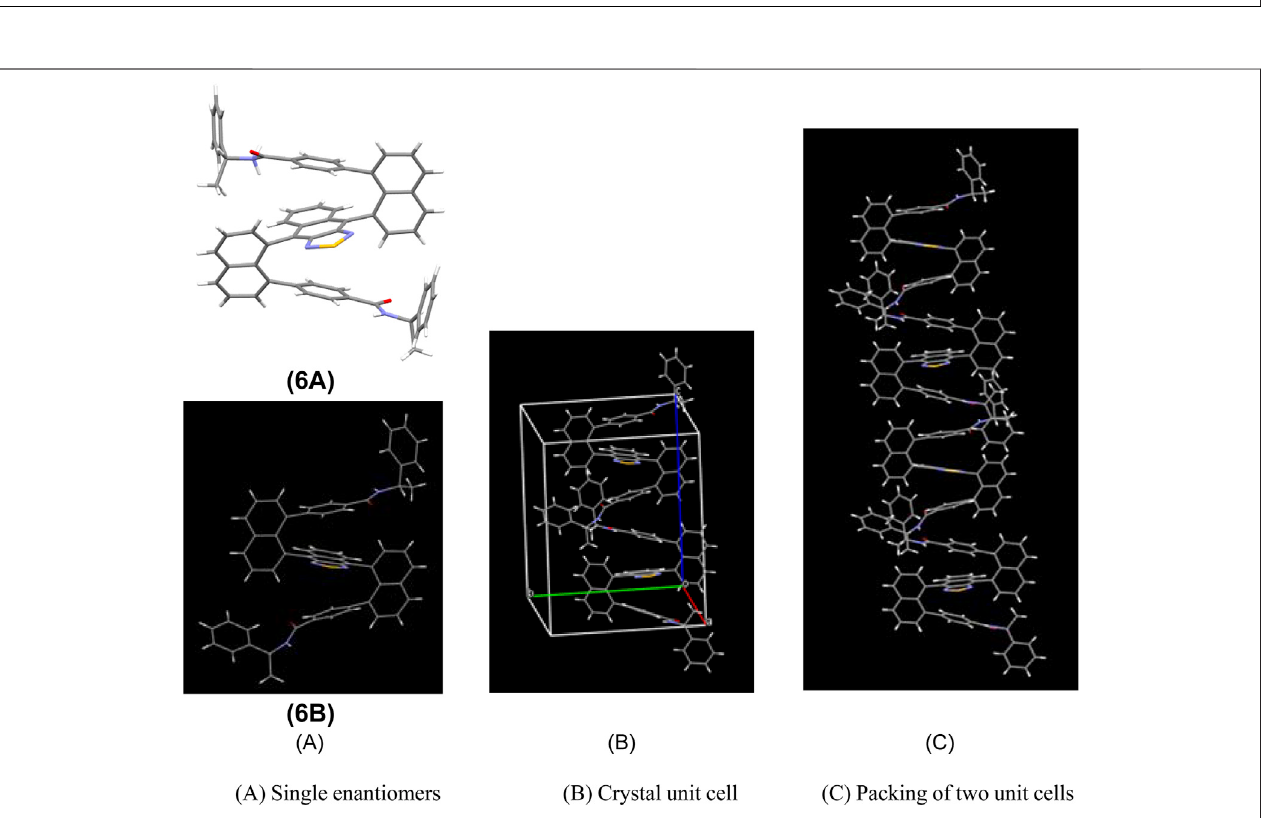
FIGURE 2 | Single-crystal structure of 6a and 6b and intermolecular packing. (A) Single enantiomers. (B) Crystal unit cell. (C) Packing of two unit cells.